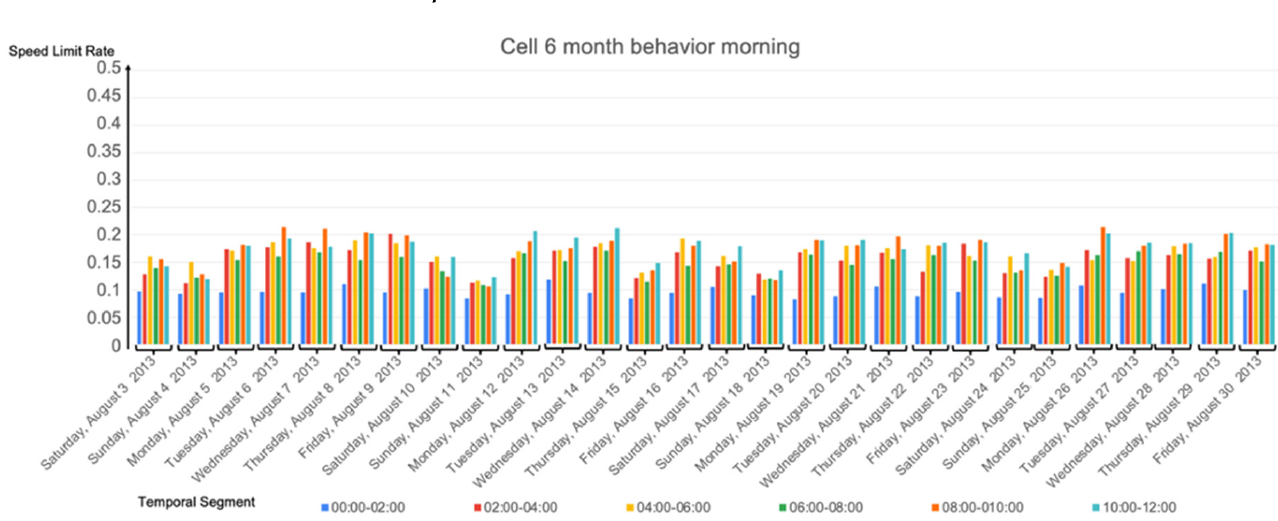
Figure A1. Results for the 28 days, cell 6 with MaxSpeed = 30 km/h in the